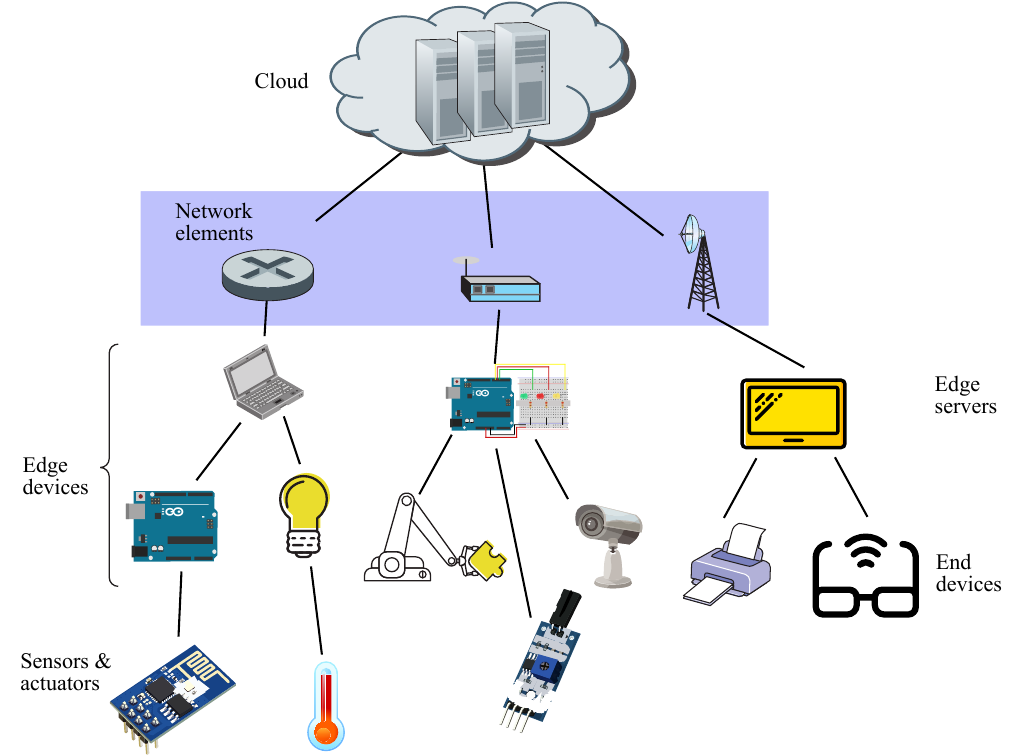
Figure 1. Schematic diagram for edge